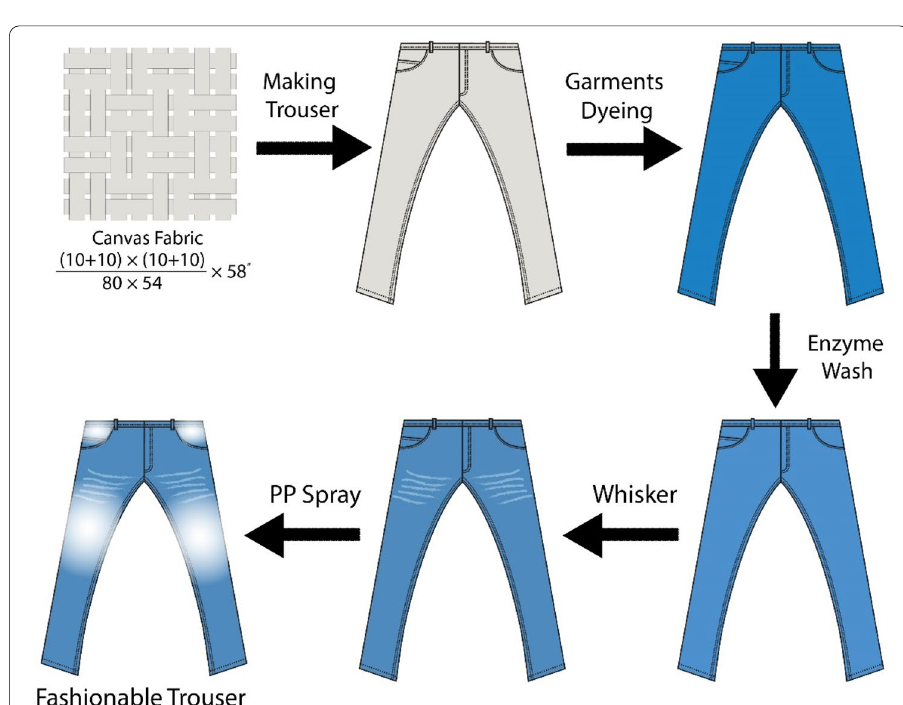
Fig. 2 Graphical abstract of this